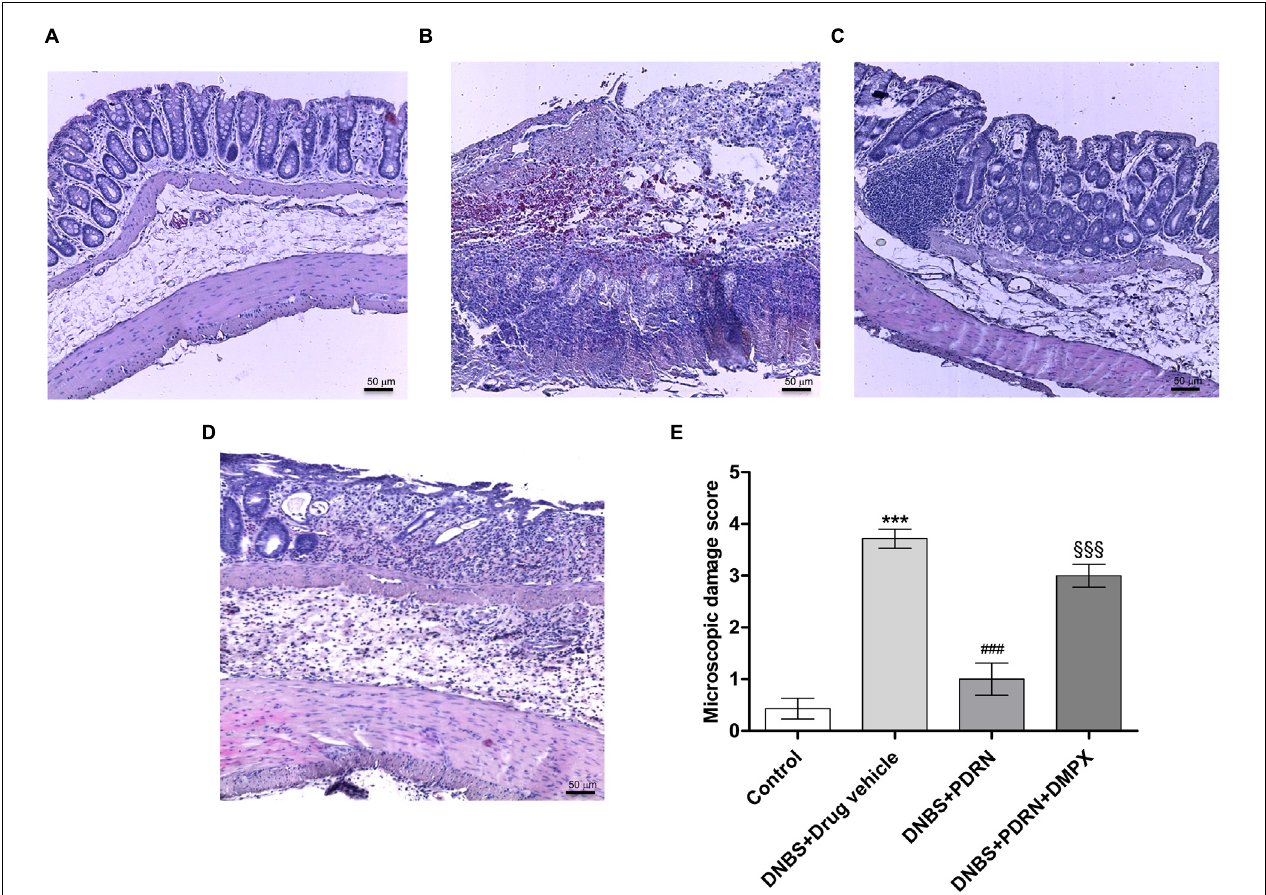
FIGURE 3 | Histological evaluations from DNBS-treated animals. Representative photomicrographs of H&E stained tissues (original magnification 10 × ) derived from control (A) , DNBS + drug vehicle (B) , DNBS + PDRN (C) , or DNBS + PDRN + DMPX (D) animals are shown. The graph represents the microscopic damage score (E) , where values are expressed as the means and SEM of seven animals. ∗∗∗ p < 0.0001 vs control group; ### p < 0.0001 vs DNBS + drug vehicle group; §§§ p < 0.0001 vs DNBS + PDRN group. Scale bar 50 µ